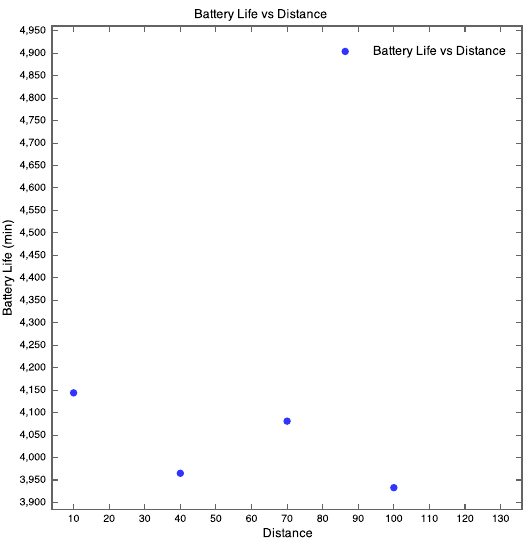
Figure 12. Battery Lifetime vs. Distance for Experiment